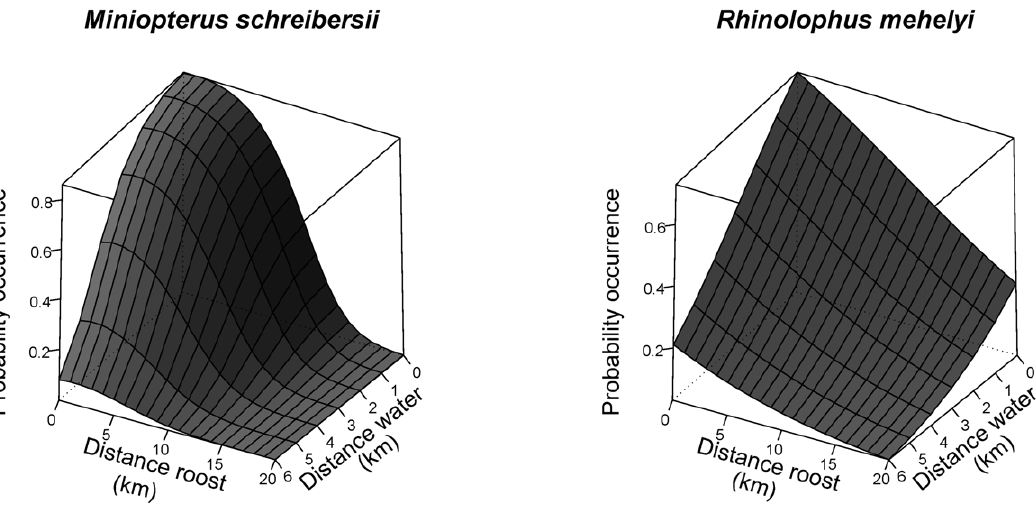
Figure 3. Estimated probability of occurrence of foraging bats, based on models using distance to roost and distance to water. Notice the great power of the two most important distance variables for both species, to explain the probability of occurrence.